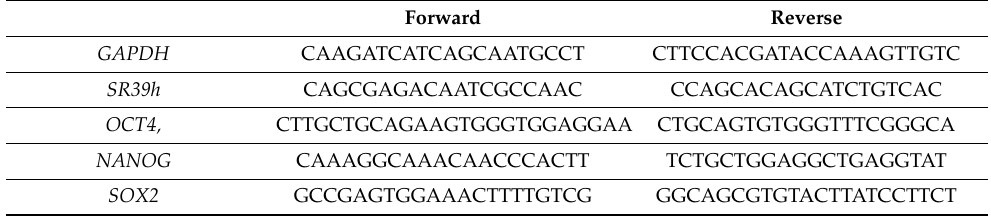
Table 1. Primer used for